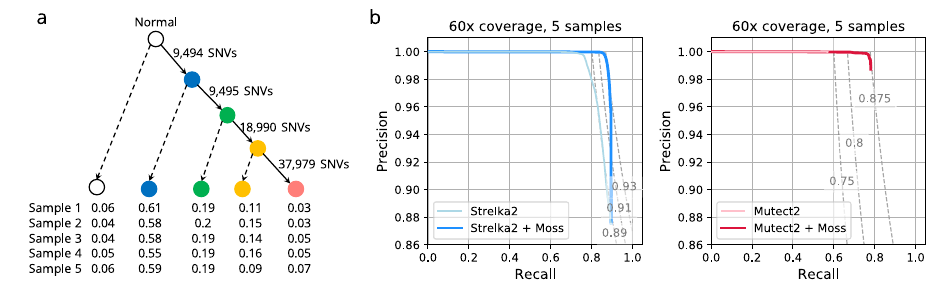
Fig. 2 Moss improves recall without loss of precision on synthetic data. a Linear phylogenetic tree with the root representing the normal clone and four additional tumor clones. Edge label indicates number of SNVs (single-nucleotide variants) newly introduced into each tumor clone. The table shows the prevalence of each clone in each sample. b Precision-recall curves of the union of SNVs identi fi ed by Strelka2 (light blue) and Mutect2 (light red) when applied independently to samples of a simulated bulk DNA sequencing dataset with 5 samples and 60× coverage, as well as when Moss is applied in conjunction with these methods (blue and red). The dashed lines represent F 1 score isolines (i.e., harmonic mean between recall and precision).